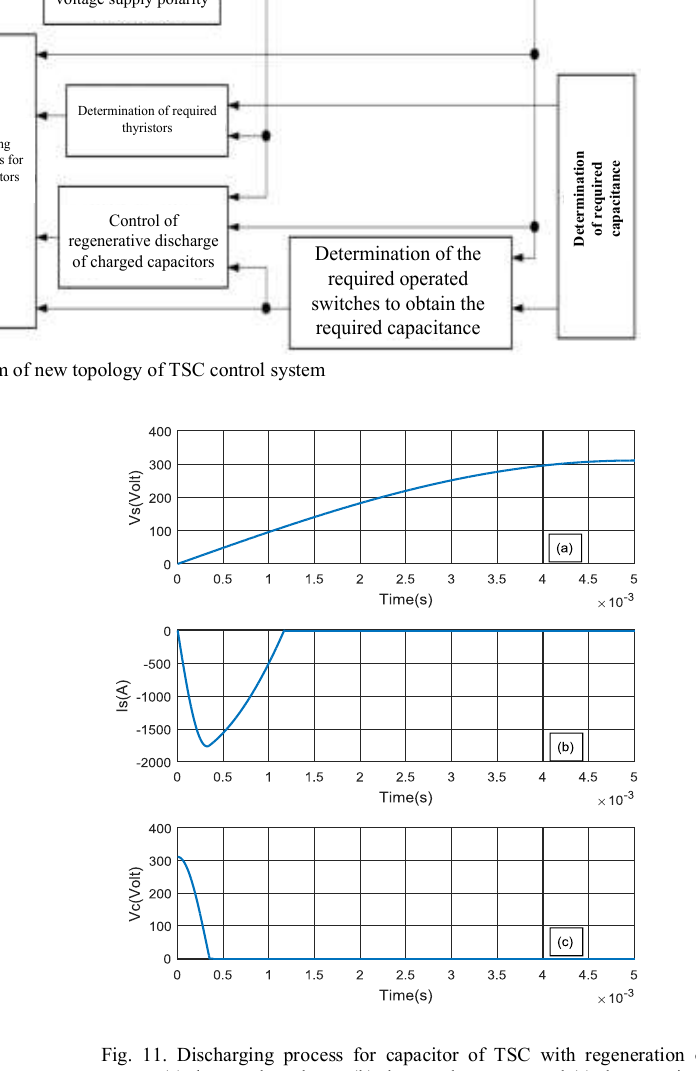
Fig. 10. The waveform of the applied voltage on TSC and its current and a voltage on one capacitor